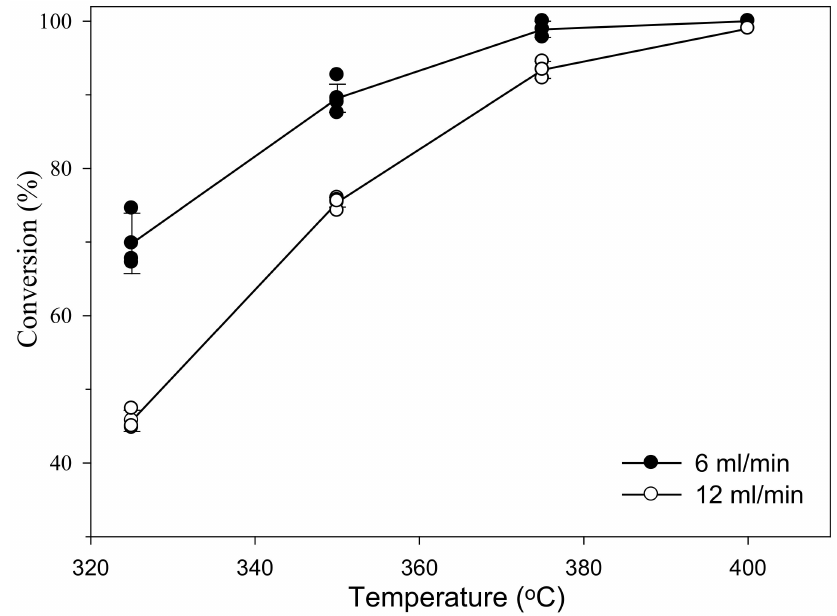
Figure 6. The variation of the ammonia conversion with temperature for Ru/C catalysts promoted with a Cs/Ru molar ratio of 4.5 and Ru loading of 3.73